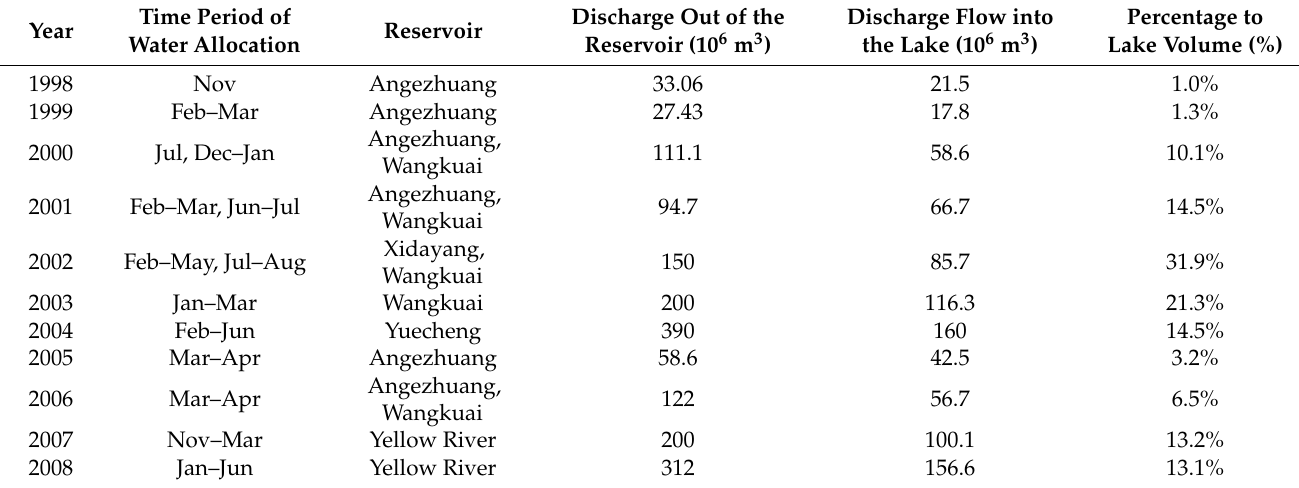
Table 1. Implementations of water allocations during